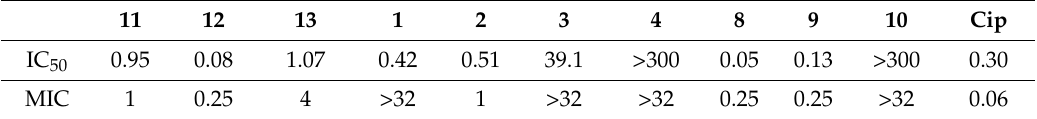
Table 7. The inhibitory activity of 1 – 4 and related compounds on the supercoiling activity of E.